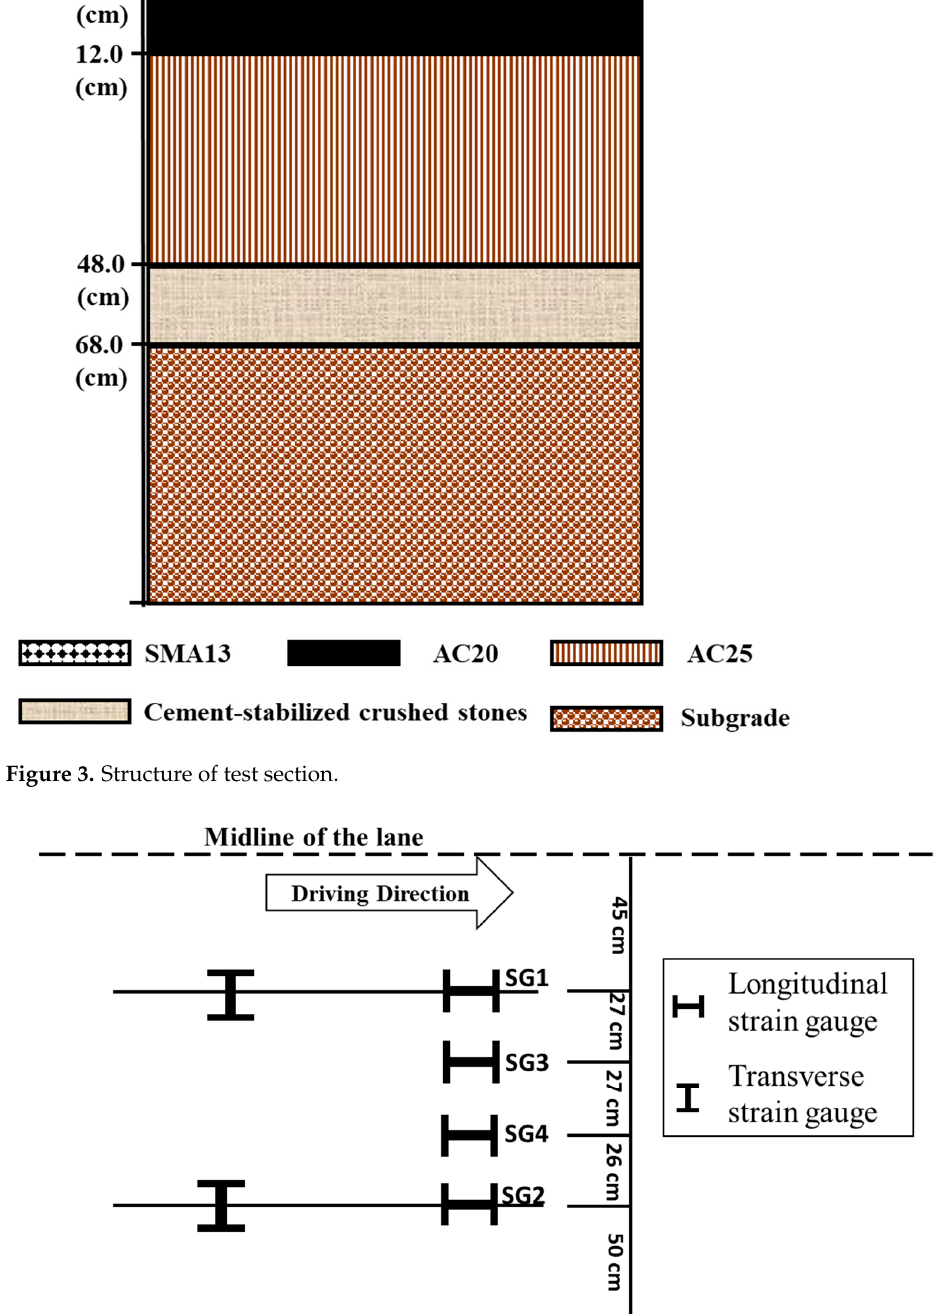
sand ‐ covered road surface to record the offset. The vehicle was driven six times for each offset position. Given that 90% of the wheels passed within the paired strain gauges (as